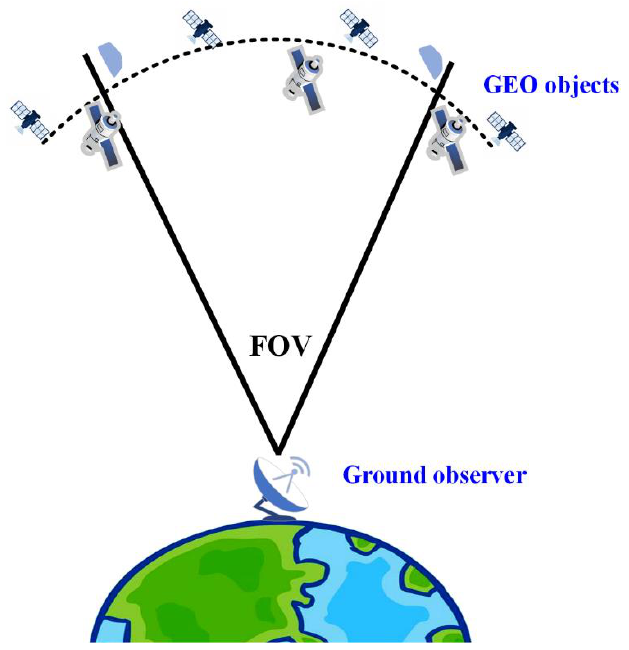
Figure 1. A diagram of a ground-based space object surveillance platform.